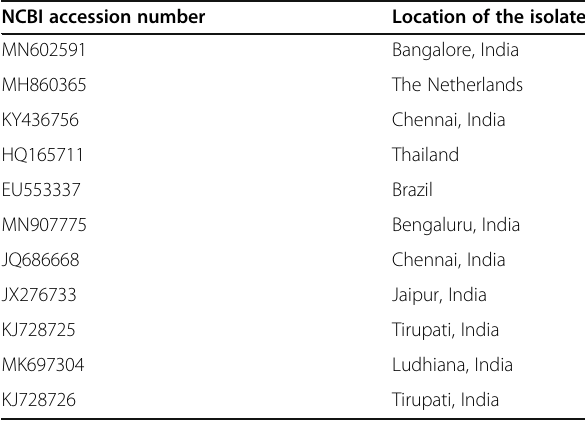
Ultrastructure of mycosis on fall armyworm Infected larvae, which are white in growth, were taken to the laboratory and placed in sterile Petri dishes contain- ing moist filter papers and then incubated at 26 °C with 70% relative humidity (RH) for 3 days to induce sporula- tion of the fungus. The infected larvae with olive green spores and the sporulating cultures of EPF on SMYA were used to study the mycosis on S . frugiperda . The mycosis of FAW was captured, using a stereo binocular microscope (Magnus MSZ-TR). was visualized by scanning electron microscopy (SEM). Samples were fixed in 2.5% gluteraldehyde in 0.1 M Table 1 The sequences along with accession numbers used from the NCBI database for the purpose of phylogenetic tree